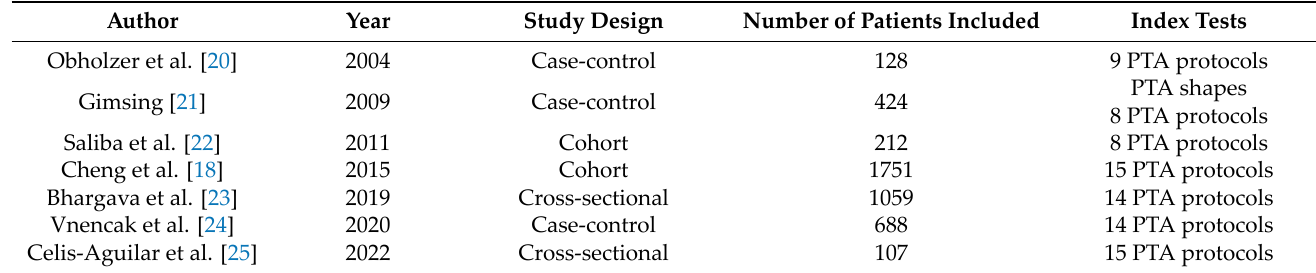
Table 1. Characteristics of the included studies.